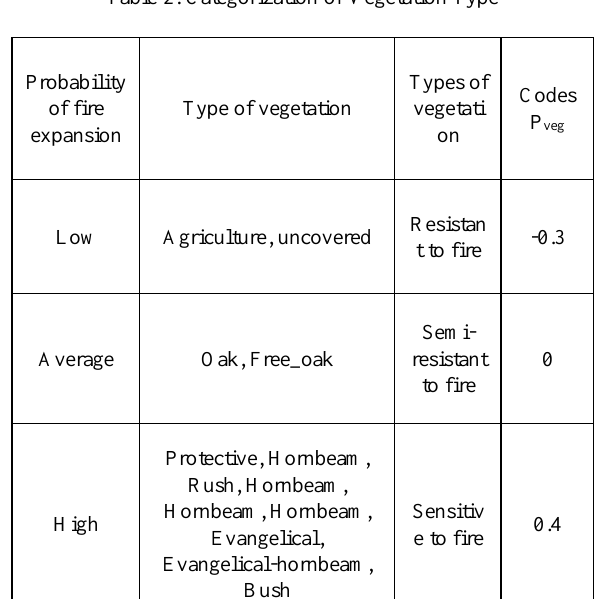
Figure 7. Map of the location of roads in the study area